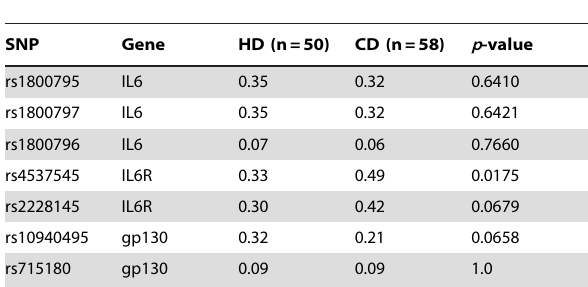
Table 2. SNP allele